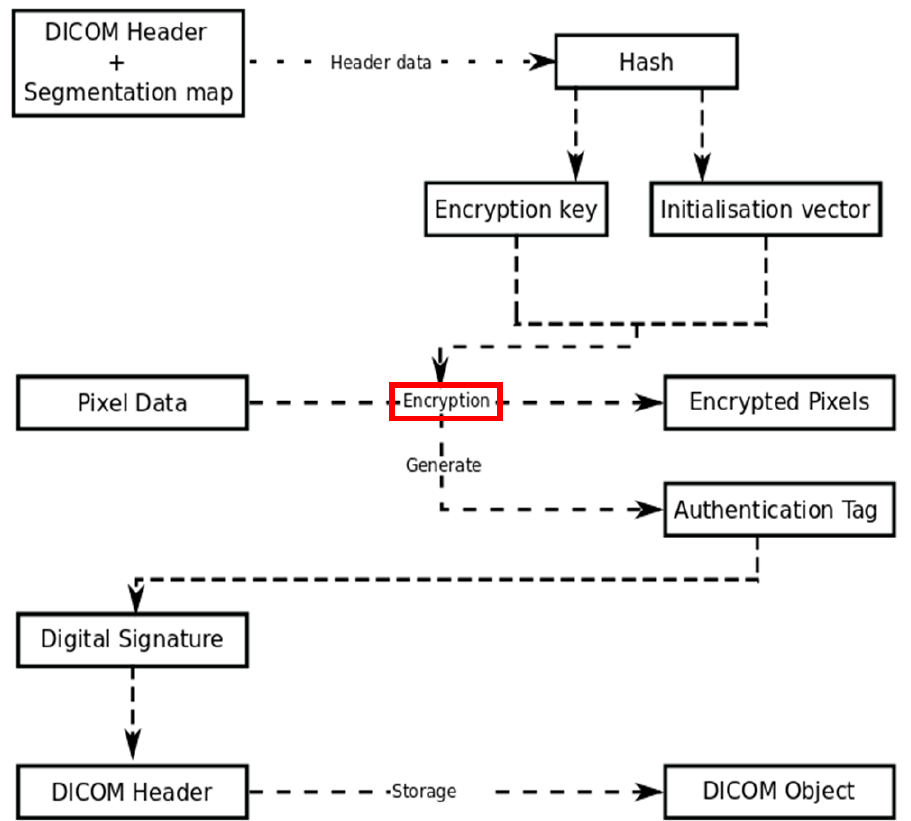
Figure 1. Encryption flow chart: Kobayashi framework, the proposed approach can contribute to reducing the computational overhead of the encryption process (red box).